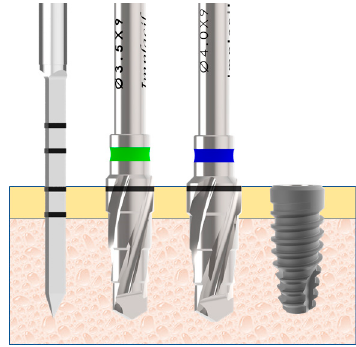
Figure 4. Representative schematic image of the drill sequence used for the osteotomy in all groups.